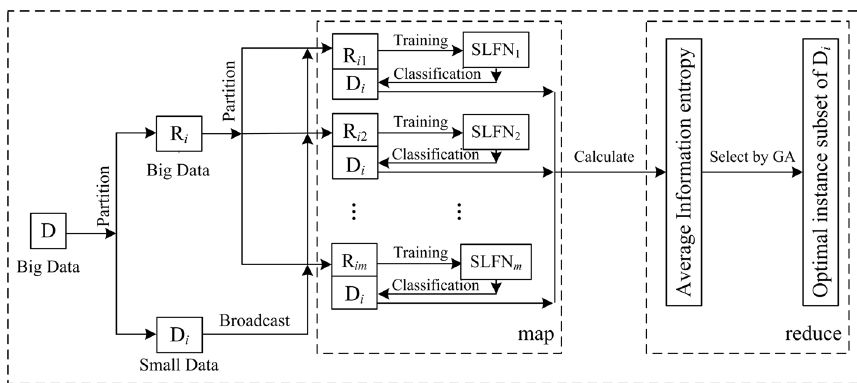
Fig. 1 The technical route of the i th round for selecting